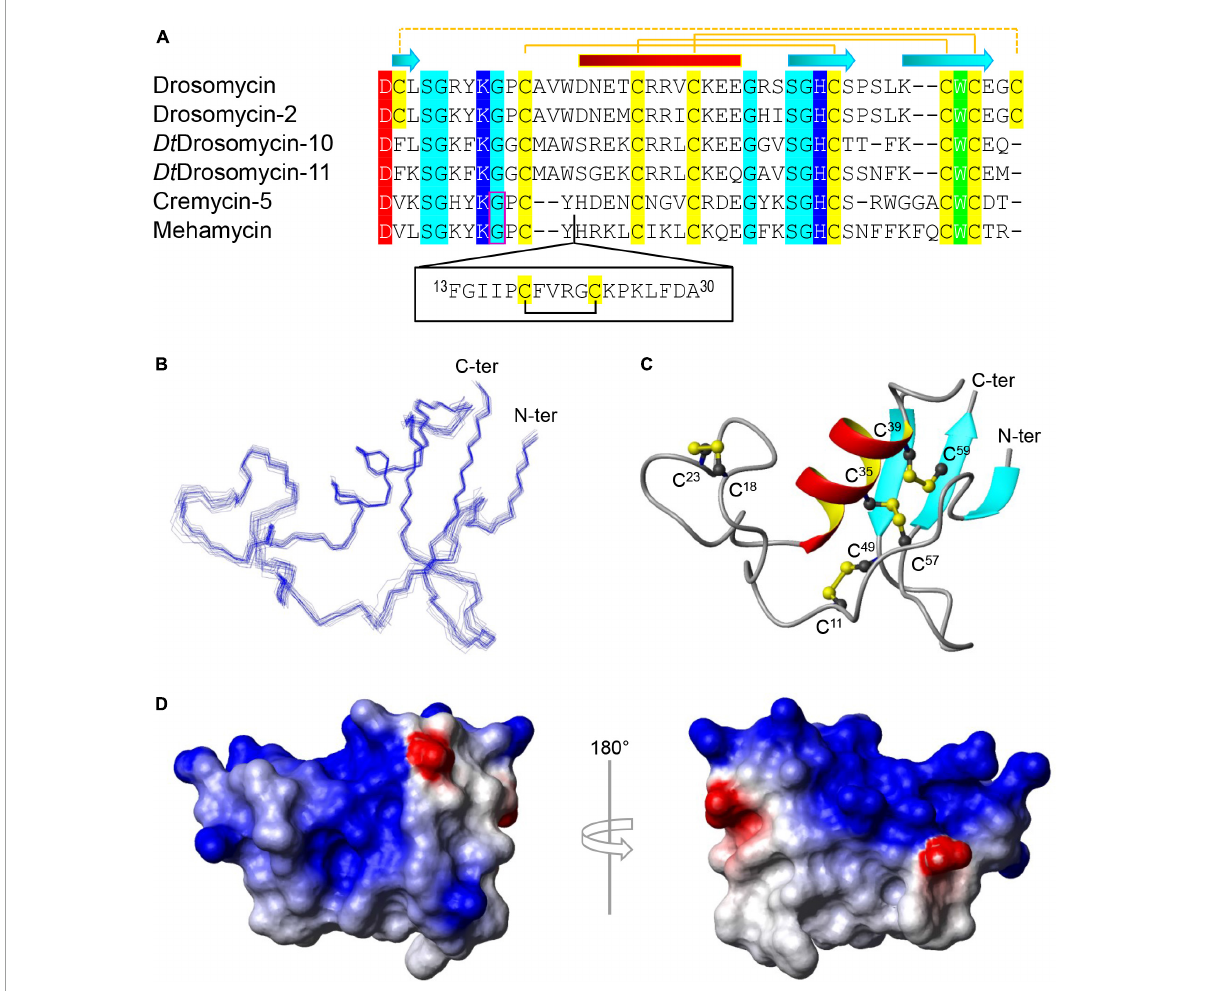
FIGURE1 Sequence and structure of mehamycin. (A) Multiple sequence alignment (MSA) of mehamycin and other representative drosomycin-type antifungal peptides (DTAFPs) from Drosophila and nematodes. Identical acidic amino acids are shaded in red, basic in blue, hydrophobic in green, hydrophilic in cyan, and all cysteines in yellow. The pairing pattern of disulfide bridges and secondary structure elements (cylinder: α -helix; arrow: β -strand) are drawn according to the structural coordinates of drosomycin (pdb entry 1MNY). The dotted line indicates the disulfide bridge absent in other members. Phase-1 introns are boxed in pink. The proposed insertion of mehamycin is boxed in black. (B–D) Solution structure of mehamycin. (B) A family of 20 lowest energy structures superimposed over the backbone atoms of residues 1–61. (C) A ribbon model of a representative structure with disulfide connectivities shown in ball and stick model. The termini are labeled with N-ter and C-ter, and cysteines with their residue numbers. (D) Surface potential distribution with negatively charged, positively charged, and electrostatically neutral zones highlighted in red, blue, and white,